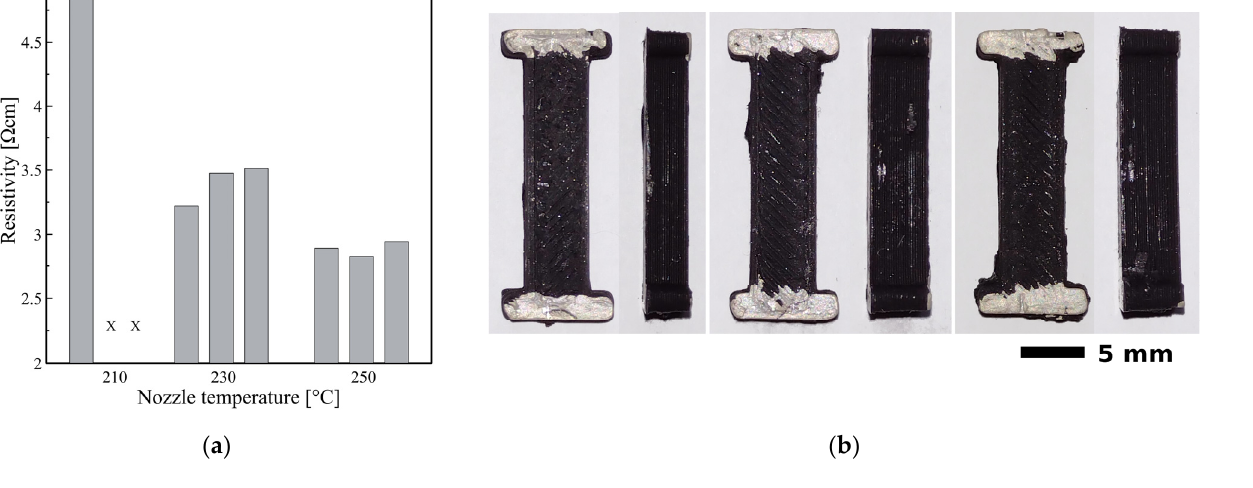
Figure 2. Results from the experiments concerning influence of the printing temperature on the quality and resistivity of the samples for temperature values 210 °C, 230 °C and 250 °C. ( a ) Resistivity values for beams printed with different nozzle temperatures—“X” mark inform about failure due to the nozzle clogging; ( b ) Images of sample beams printed with different nozzle temperatures (from left): 210 °C, 230 °C and 250 °C, respectively.